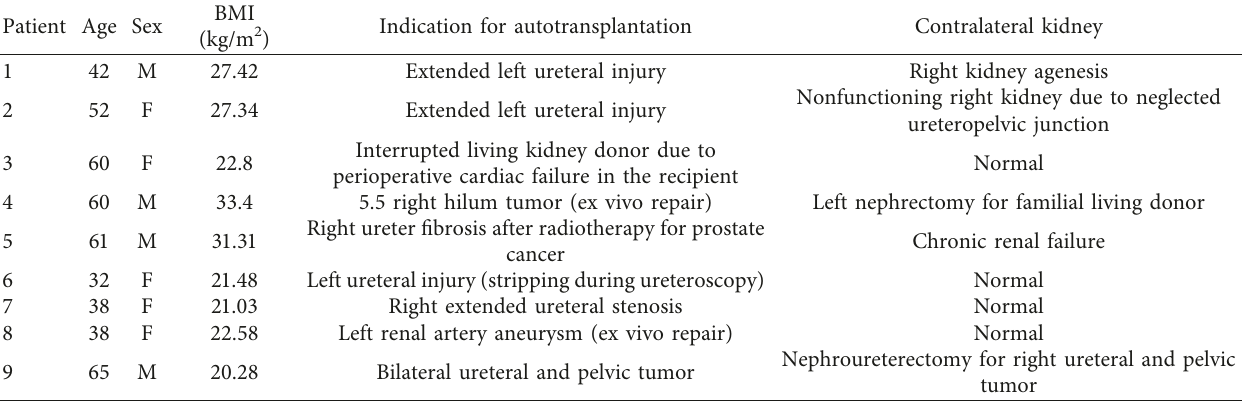
Table 1: Demographic and preoperative data in study population.